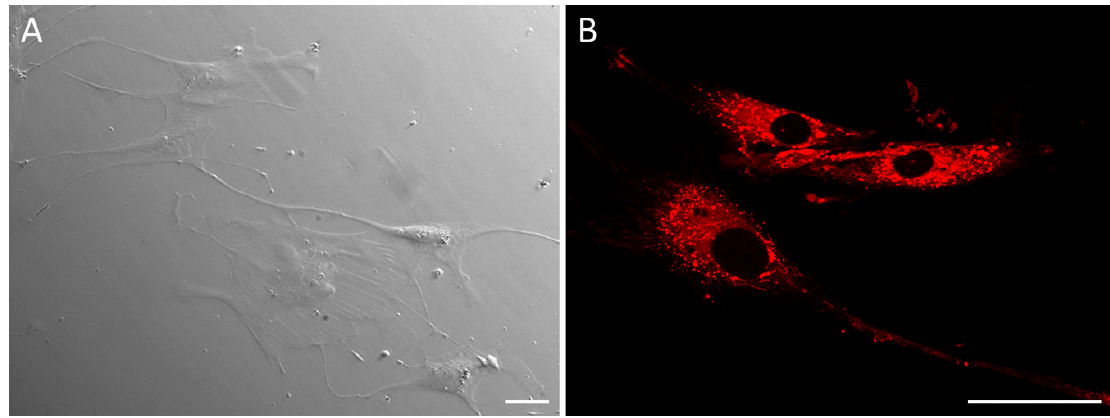
Figure 1. Human mesenchymal stem cells (hMSCs) treated with rhodamine-derived superparamagnetic maghemite nanoparticles (SAMN-R). ( A ) Integrated modulation contrast in wide-field microscopy, 40× magnification; ( B ) confocal microscopy, 63× magnification. Scale bar 50 µm.